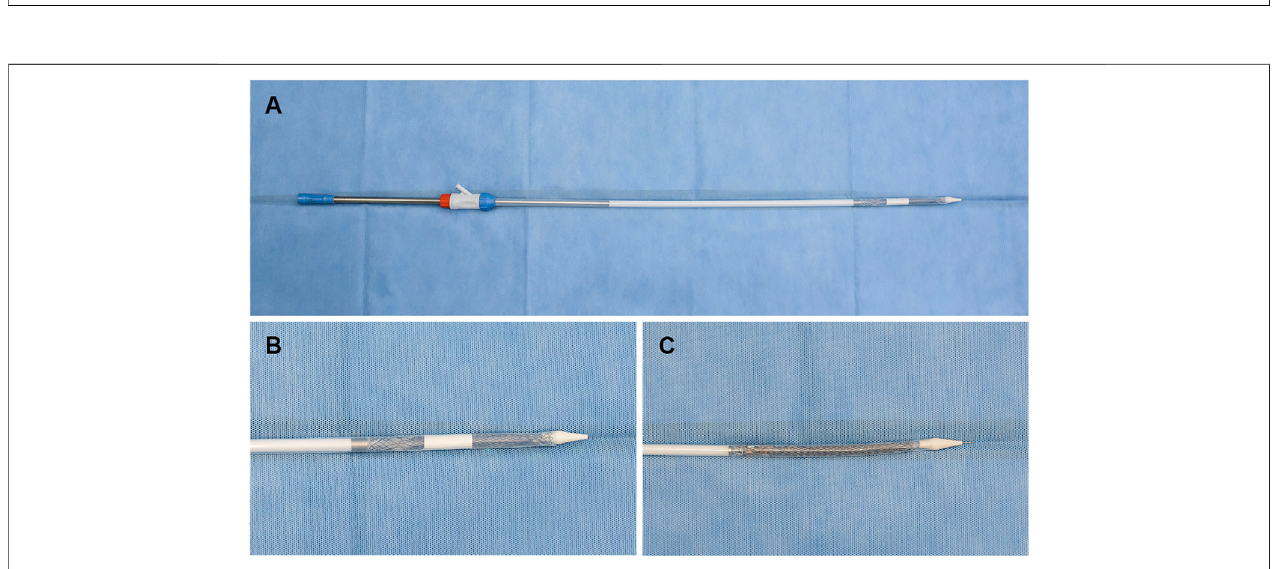
FIGURE2| RepresentativeimagesshowingFCSEMSwithADMandstandardFCSEMS. (A,B) OutcomeofFCSEMSwithADM:FCSEMSiscoveredbytheADMin the middle and upper part of the stent and is inserted in the stent conveyer. (C) The appearance of FCSEMS. FCSEMS, fully covered self-expanding metal stent; ADM, acellular dermal